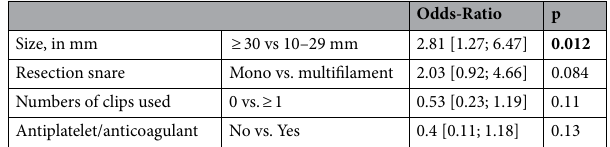
Table 5. Adverse events after endoscopic mucosal resection for duodenal adenomas in multivariate